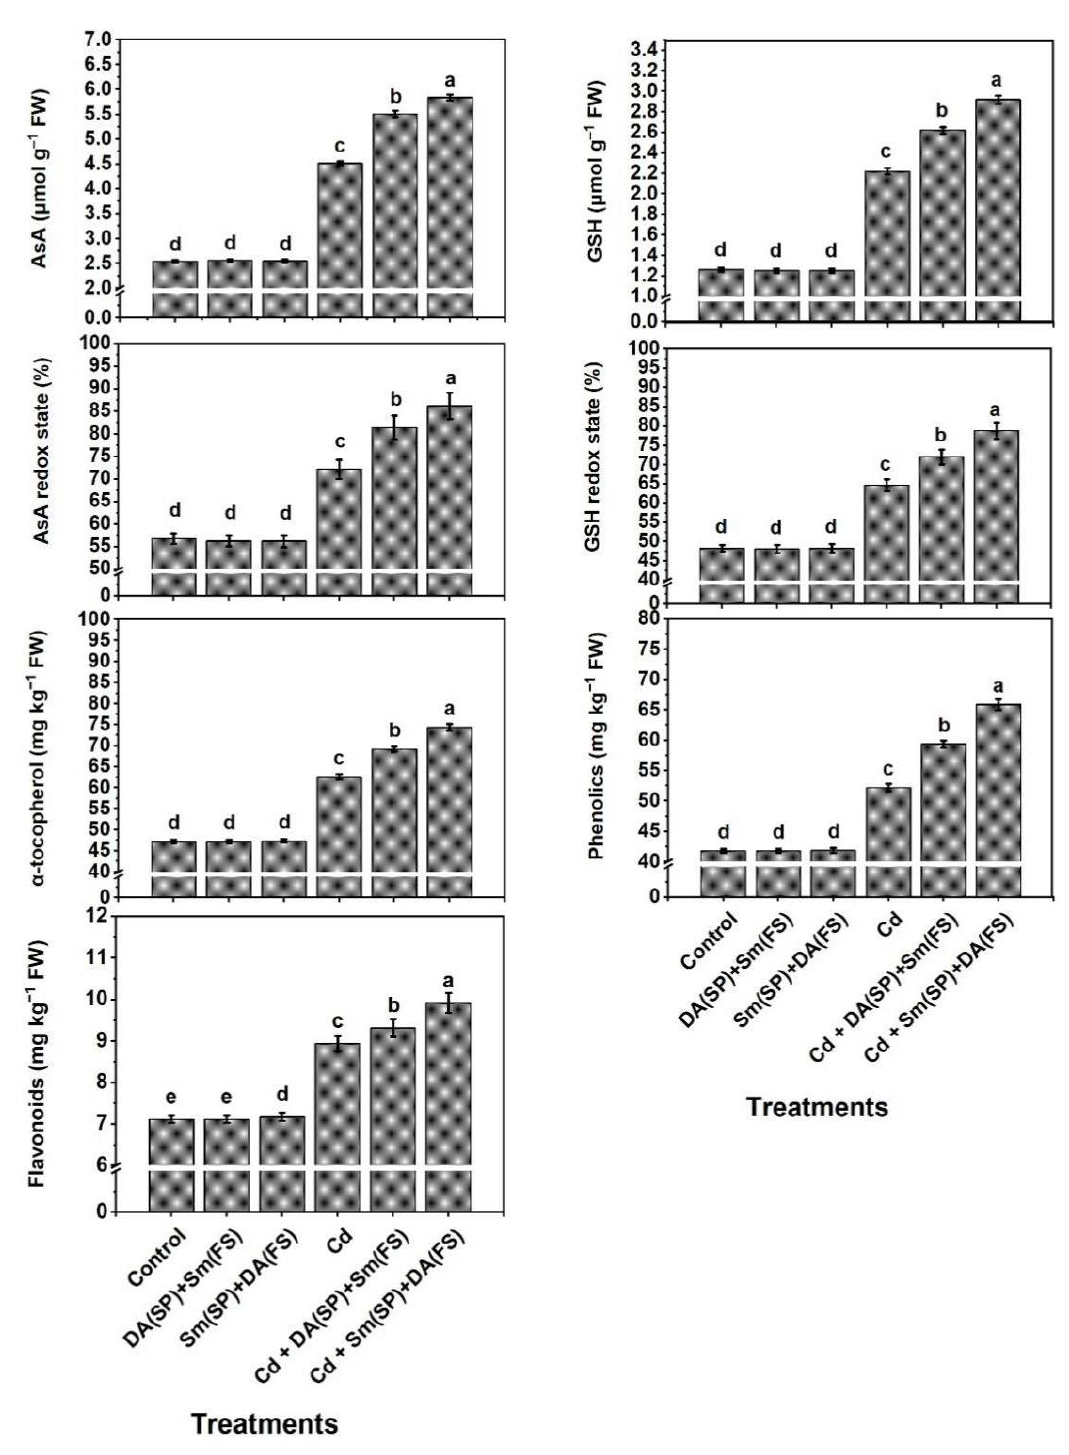
Figure 6. Effects of seed priming (SP) and foliar spraying (FS) with silymarin (Sm) or dopamine (DA) on non-enzymatic antioxidant levels of cadmium-stressed Phaseolus vulgaris plants. Columns labeled with same or different letters within each plot signify non-significant or significant differences, respectively, based on LSD test ( p ≤ 0.05). Bars represent SE values (three replicates). AsA = Ascorbate, GSH = Glutathione.